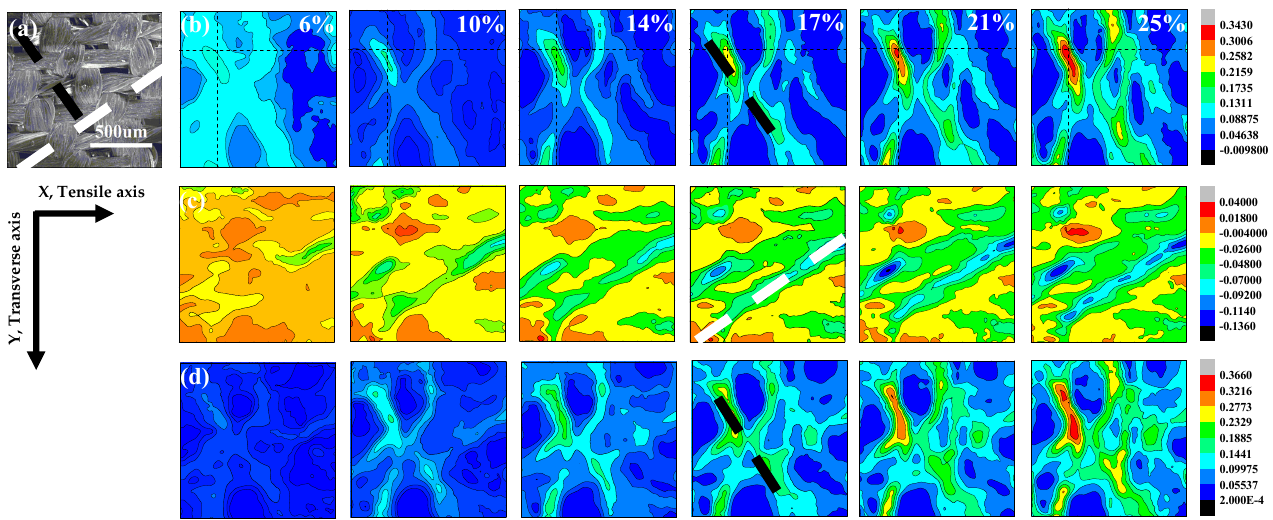
Figure 5. DIC images of strained 90° specimen: ( a ) Speckle image of the 90° specimen before loading. ( b ) Contour maps of the ε xmax field. ( c ) contour maps of the ε ymax field. ( d ) contour maps of the γ max field.